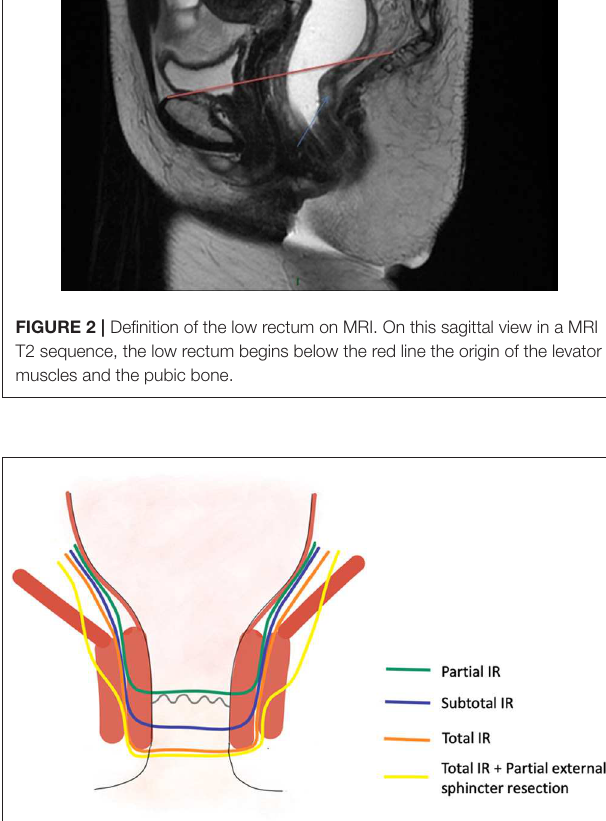
FIGURE 3 | Classification of the very low rectal cancer according to the Rullier’s classification ( 8). The dotted lines indicate the surgical dissection plan required based on the location of the lesion.